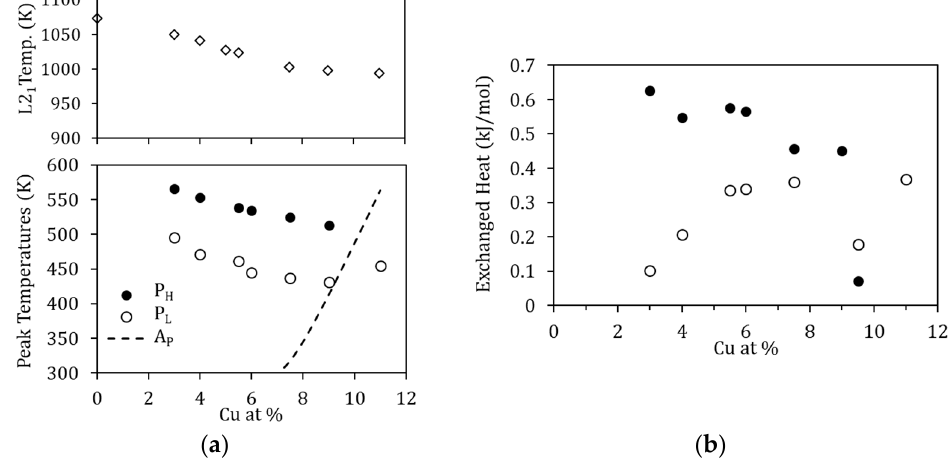
Figure 11. ( a ) Peak temperature of P L and P H , together with the temperature of the B2 ↔ L2 1 ordering transition, as a function of the Cu-content; the dashed line shows the reverse MT temperature; ( b ) Heat released during the processes P L and P H as a function of the Cu-content.